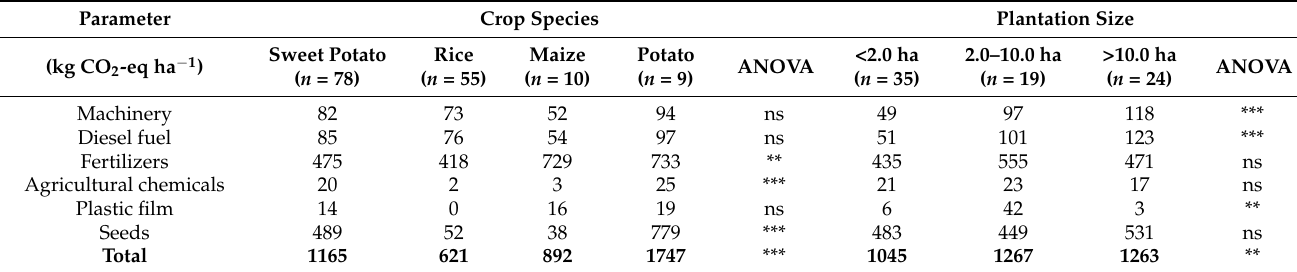
Table 7. GHG emissions of different crop production (including sweet potato, rice, maize, and potato) and different plantation sizes of sweet potato production in Guangdong.